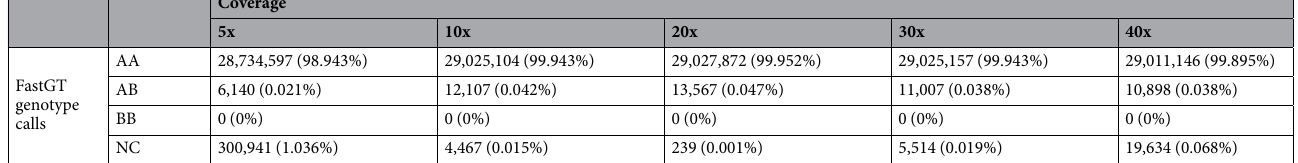
Table 1. Genotypes retrieved from the simulated reads generated from the reference genome. “A” denotes the allele from the reference genome, and “B” denotes the alternative allele. “NC” is no-call.